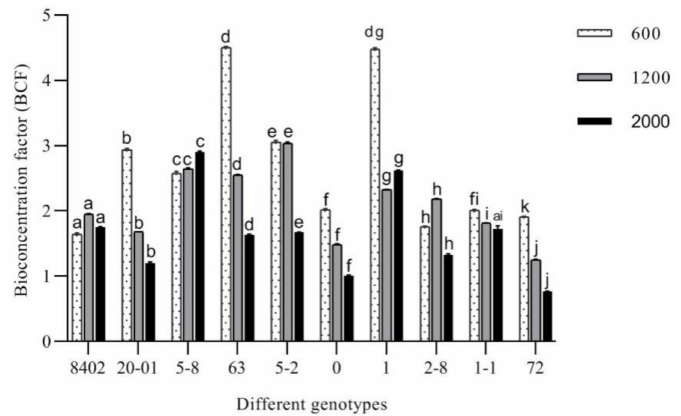
Figure 8. Bioconcentration factors of C. bungei . Note: Different letters at the same Sb concentration indicate significant differences among the treatments at p < 0.05 ( n = 3). The same below.